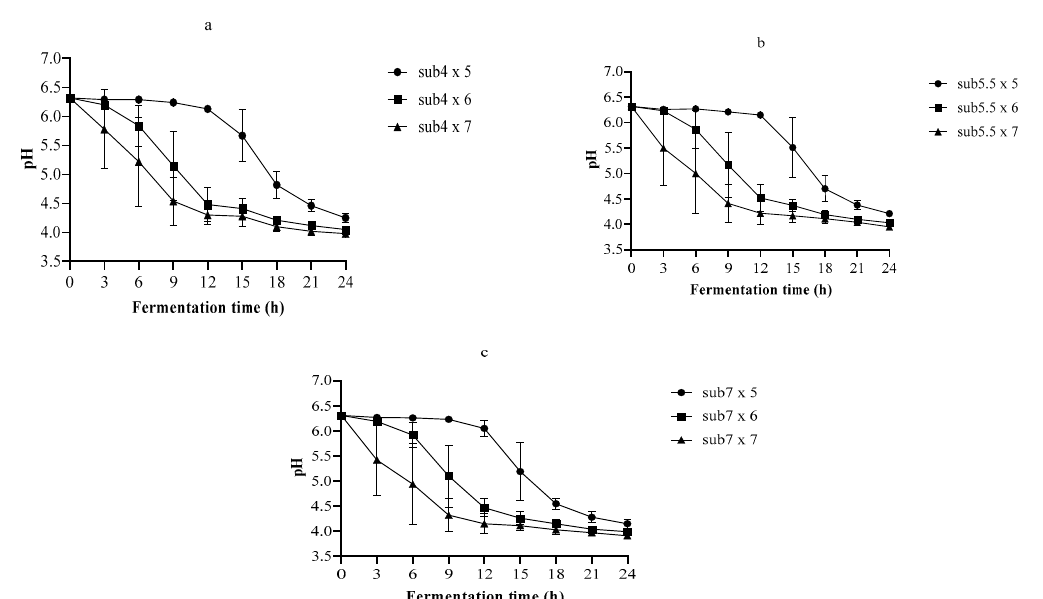
Figure 2. The pH changes during fermentation of ( a ) 4% w / v , ( b ) 5.5% w / v , and ( c ) 7% w / v substrate with Lactobacillus plantarum A6; sub4 × 5, 4% w / v substrate inoculated with 5 log cfu/mL; sub4 × 6, 4% w / v substrate inoculated with 6 log cfu/mL; sub4 × 7, 4% w / v substrate inoculated with 7 log cfu/mL; sub5.5 × 5, 5.5% w / v substrate inoculated with 5 log cfu/mL; sub5.5 × 6, 5.5% w / v substrate inoculated with 6 log cfu/mL; sub5.5 × 7, 5.5% w / v substrate inoculated with 7 log cfu/mL; sub7 × 5, 7% w / v substrate inoculated with 5 log cfu/mL; sub7 × 6, 7% w / v substrate inoculated with 6 log cfu/mL; sub7 × 7, 7% w / v substrate inoculated with 7 log cfu/mL.